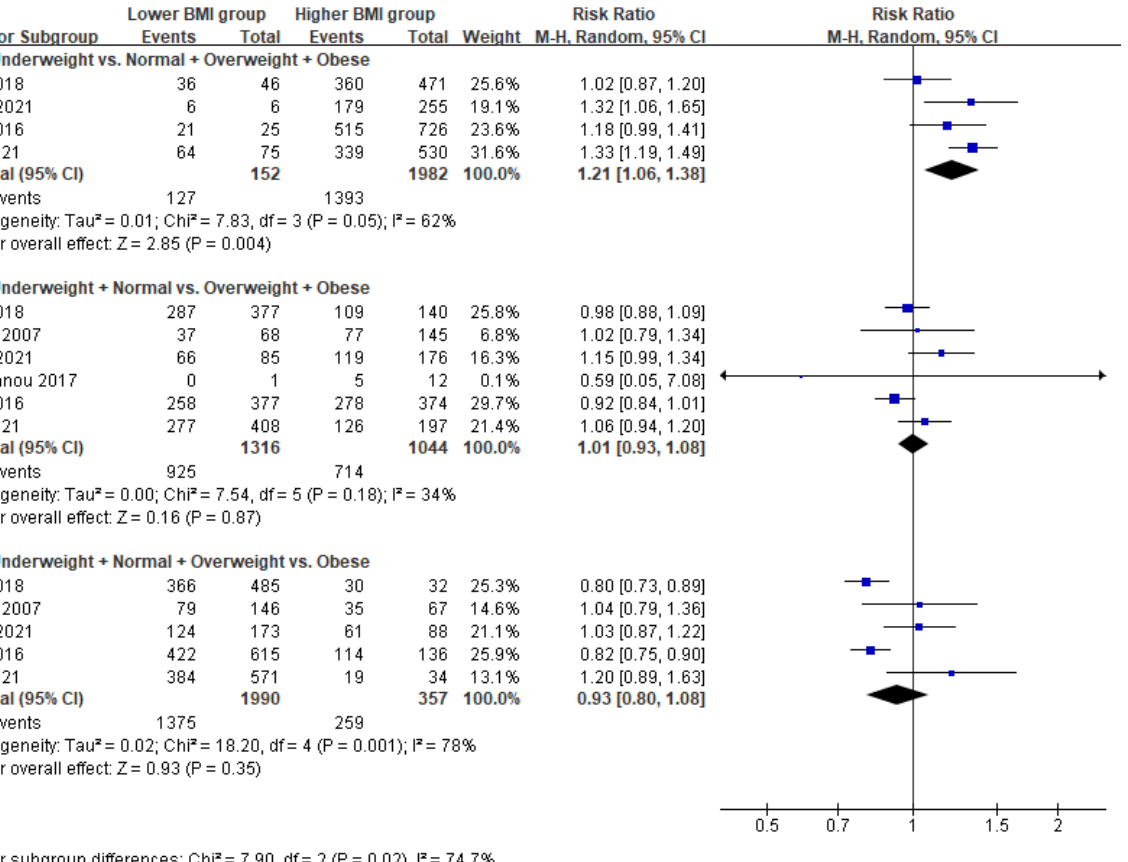
Figure 3. Forest plot of the association between body mass index and neurological outcomes in patients with return of spontaneous circulation after out-of-hospital cardiac arrest.